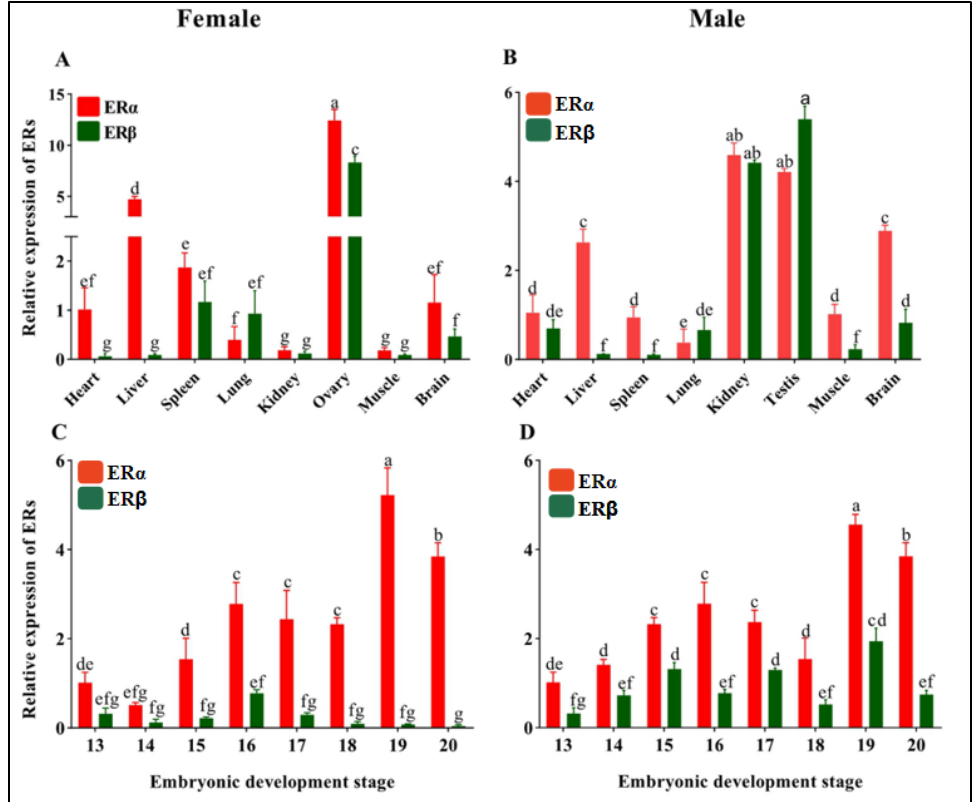
Figure 3. Expression profiles of ERs cloned from P. sinensis in normal adult females ( A ) and male tissues ( B ), and expression analysis in blank group female embryos ( C ) and male embryos ( D ) at different embryonic development stages. Data are mean ± SD (n = 3). Significant differences at P < 0.05 are labeled with different letters.